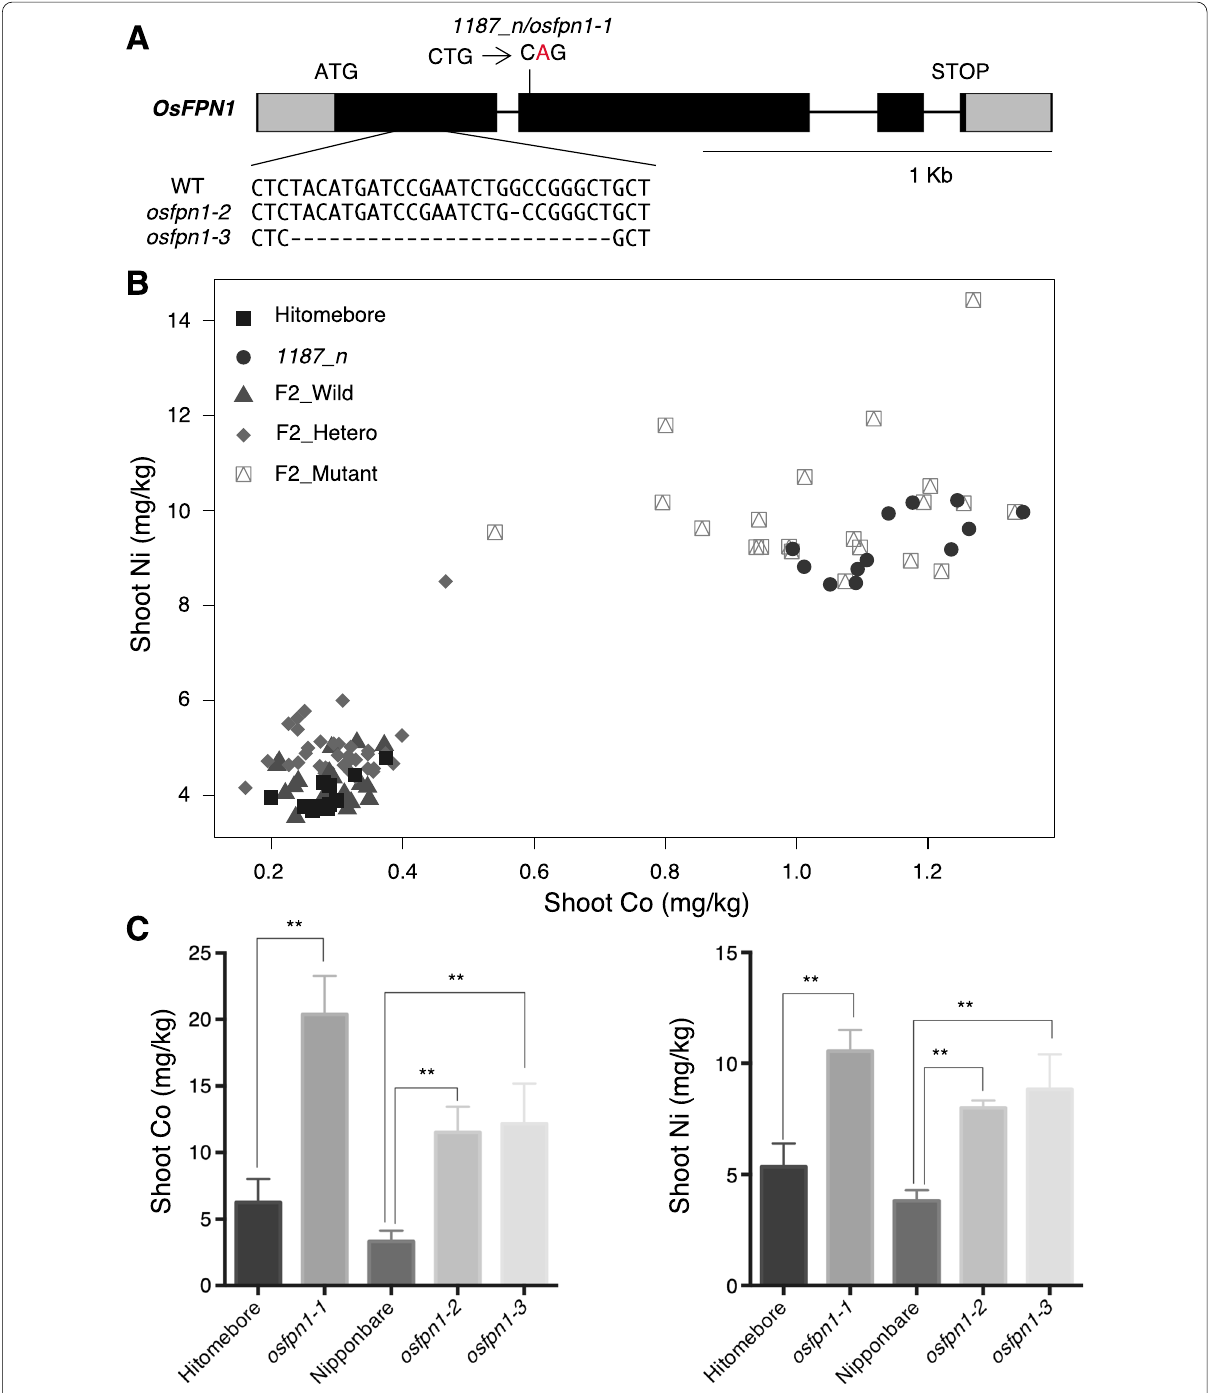
Fig. 3 Responsibility of OsFPN1 for the phenotype of 1187_n. A Exon intron structure of OsFPN1 . Gray boxes, dark boxes, and lines represent the untranslated region, exon, and intron, respectively. OsFPN1 of 1187_n has a nonsynonymous mutation of T to G [leucine (L) is replaced with glutamine (G)]. Osfpn1-2 and osfpn1-3 are CRISPR/Cas 9 mutants with 1 bp and 26 bp deletions at the first exon of OsFPN1 , respectively. WT (Nipponbare) is the background of the mutants. B Scatterplot based on the Co and Ni concentrations in the shoots of three-week-old seedlings of Hitomebore, 1187_n , and F2. F2_Wild, F2_Hetero, and F2_Mutant represent the wild-type, heterozygous, and mutant homozygous genotypes of F2, respectively. C Co and Ni concentrations in the shoots of Hitomebore, osfpn1-1 , Nipponbare, osfpn1-2, and osfpn1-3 . Plants were grown in Kimura B solution supplied with 10 trace elements. Data represent the means SD (n 3–12). Student’s t -test (compared to Hitomebore or Nipponbare). ± = **p <